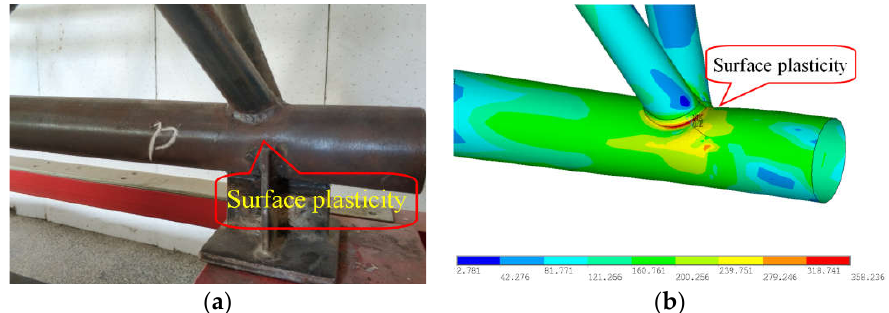
Figure 19. Comparison of experimental and FEA failure mode for specimen T-HW at the joint ‘p’. ( a ) Experimental; ( b ) FEA analysis